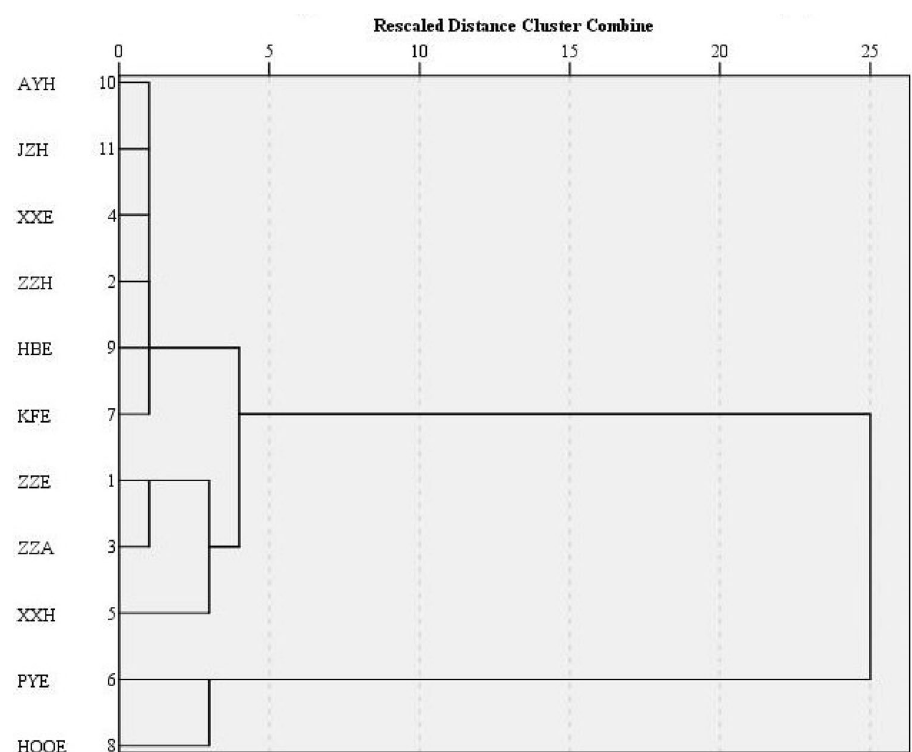
Figure 5. Dendrogram of industrial park by 5 indicators using hierarchical cluster